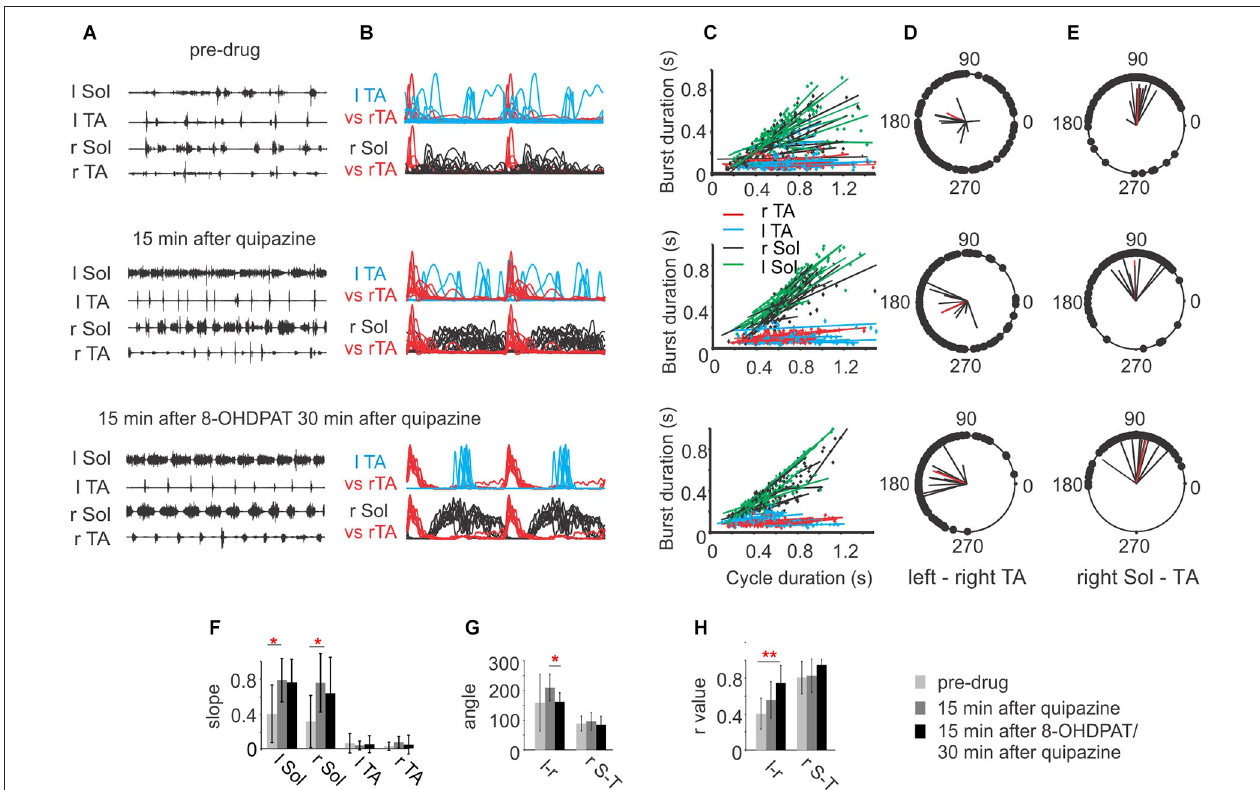
activity in the right Sol (intralimb coordination in E ), the black lines each represent results of analysis established for one animal and the red line represents the average results across animals in the analyzed group. (F) Bar diagrams showing the mean slopes ( ± SD) for the regression lines between step cycle durations and burst durations for the left and right TA and Sol muscles in rats in locomotor hindlimb movements in the three experimental conditions. (G) Bar diagrams showing the means ( ± SD) of the angle of the left–right TA (l–r) and of the right Sol–right TA (r S–T) relationships (relative timing of the onsets for the two muscles) represented in each polar plot in the three experimental conditions. (H) Bar diagrams showing the means ( ± SD) of r -value between the times of onset of activity in both left-right and flexor-extensor EMG established for spinal rats ( n = 5) in the three experimental conditions. Each rat was tested twice with at least a week’s delay between tests. * P < 0.05, ** P < 0.01, statistical significance established by one-way repeated measures ANOVA followed by Tukey’s post-hoc